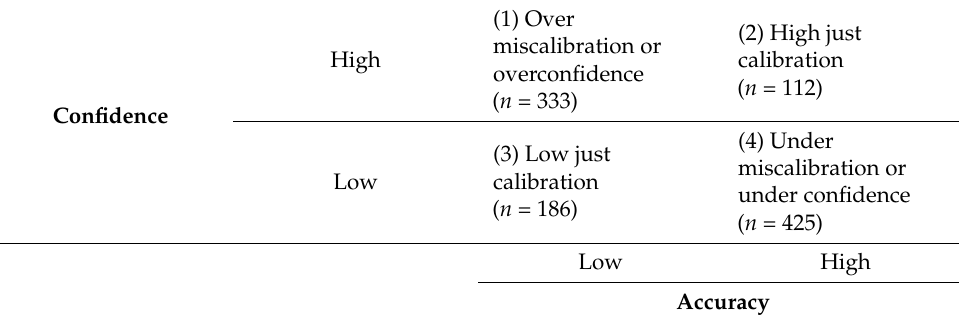
Table 1. Calibration of accuracy, confidence, and